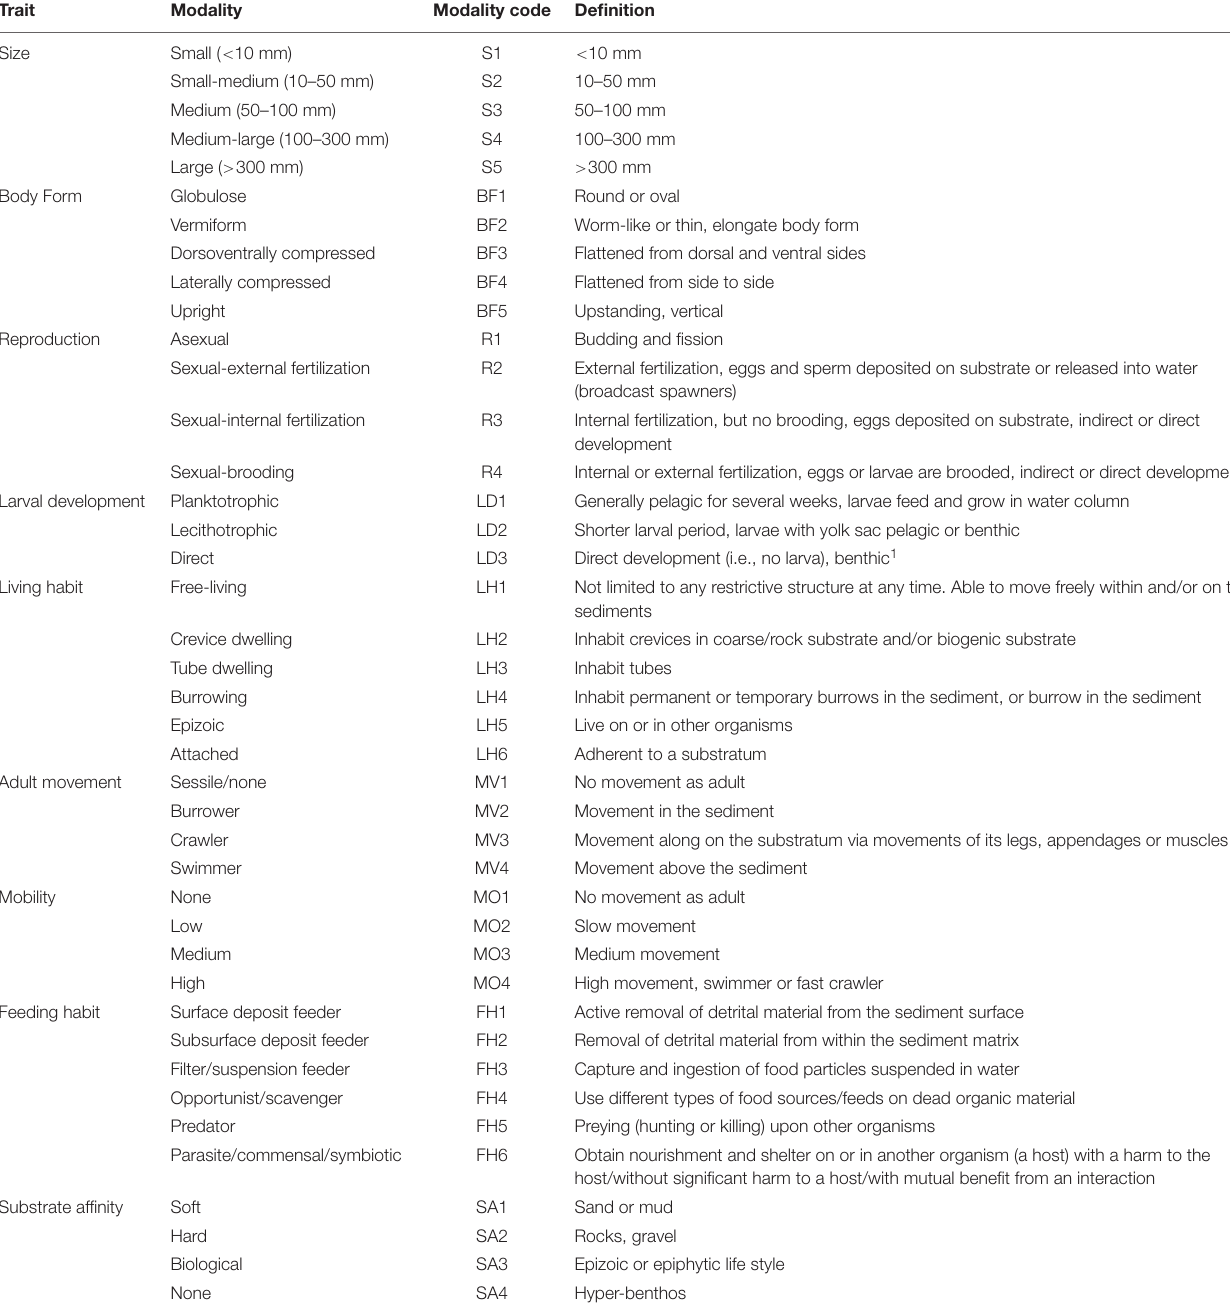
TABLE 2 | Overview of traits and their modalities used in the present paper.